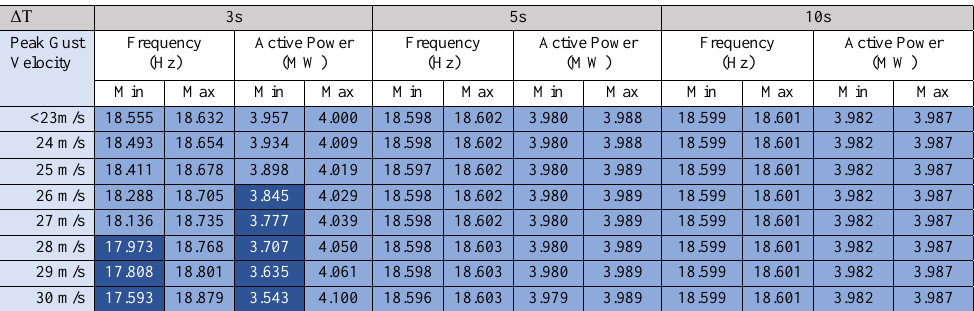
Figure 11. Bus active power response to 3 s ECG gusts. The remaining simulations for ECGs with ∆ = 5 s and ∆ = 10 s all show performance within the 5% tolerance level. The 8 degrees/s of pitch angle control is capable of damping response without becoming saturated. The results of all the simulations are tabulated in Table 3. The light blue segments denote the respective criteria are satisfied while dark blue denotes that one or both of the ± 2.5% threshold levels have been exceeded. Considering the 5 s and 10 s rise time simulations, it can be observed that ECGs up to 30 m/s can be tolerated by the system. The maximum gust factors for these events of 1.64 through 2.14 are well beyond the gust factors measures at the coastal wind site in Frøya [37]. The 3 s ECG is within limits up to and including a V Gust max of 25 m/s. With a gust factor of 1.79 from Table 2, this 25 m/s gust is well above the measured gust factors at this site with a mode value of 1.20. Table 3. This table displays the results of all ECG simulations completed. Light Blue demonstrates the respective responses remain within the ± 2.5% boundary limitations with dark blue showing the criteria has not been met. The minimum and maximum values of both frequency and active power reached during each gust are